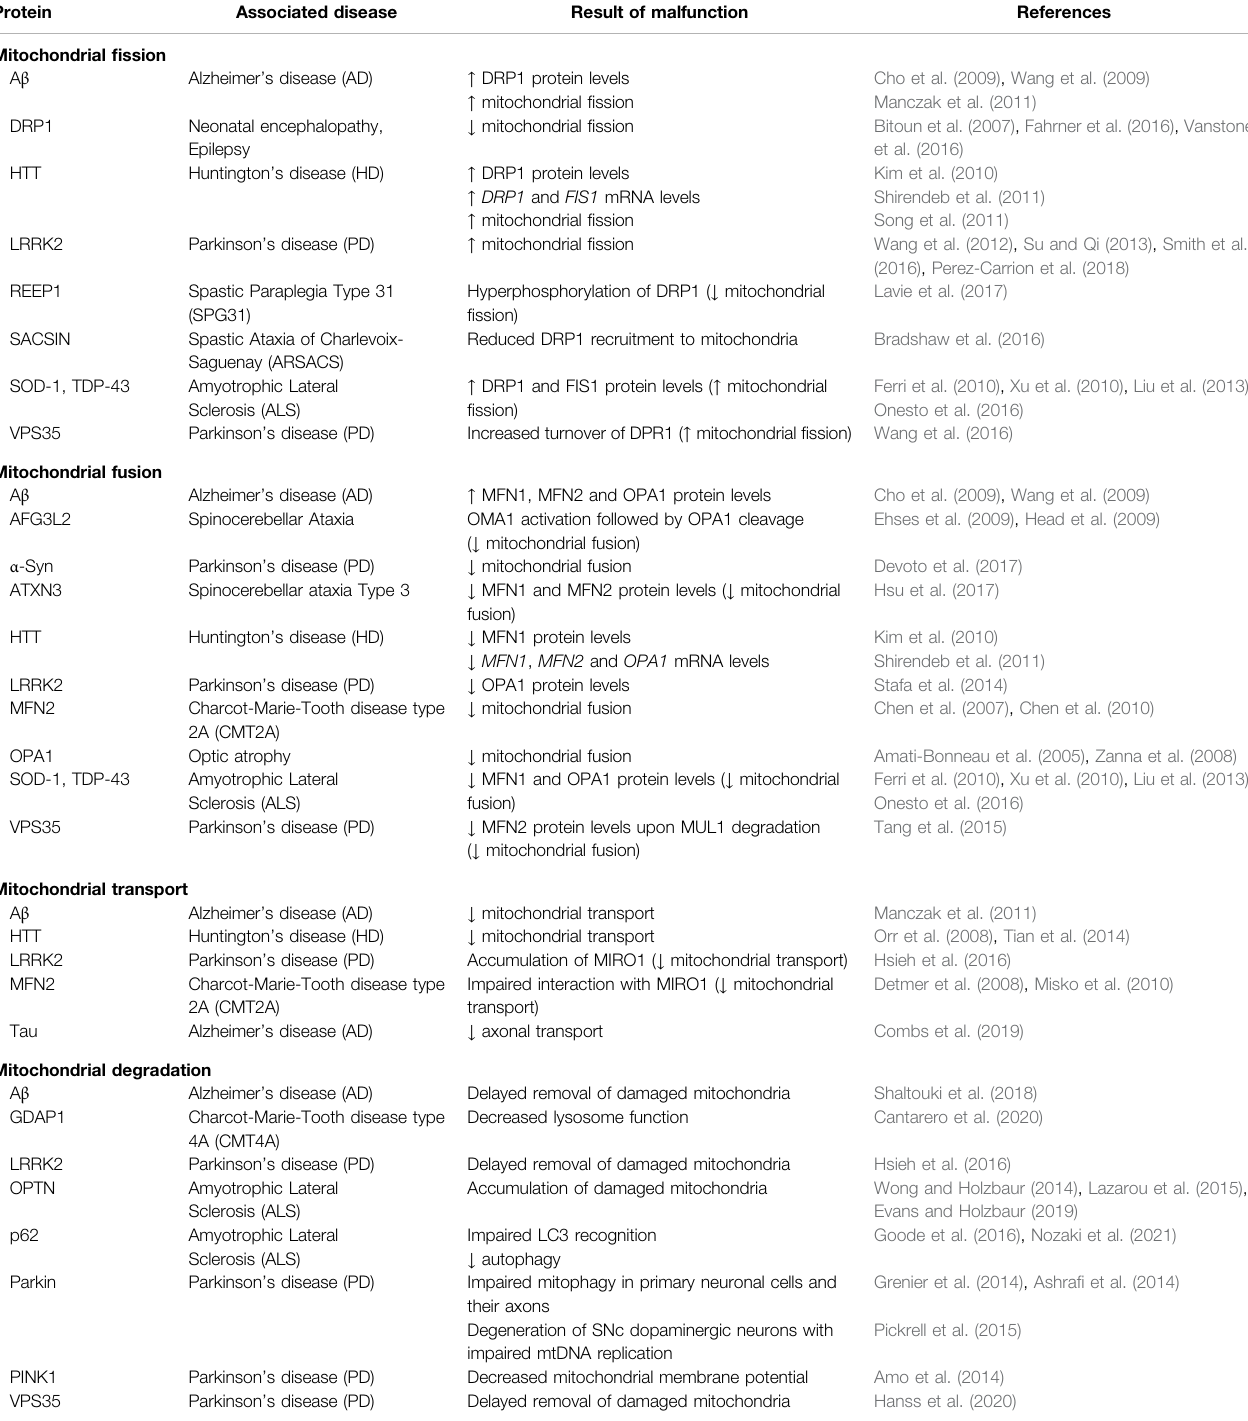
TABLE 2 | Proteins related to impaired mitochondrial